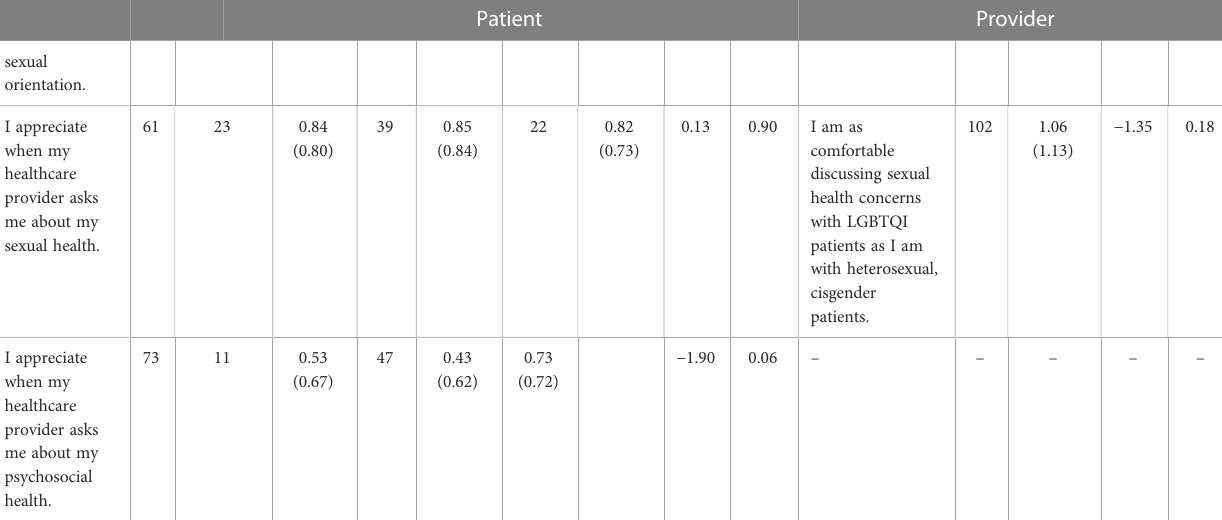
Bold values represent statistical signi fi